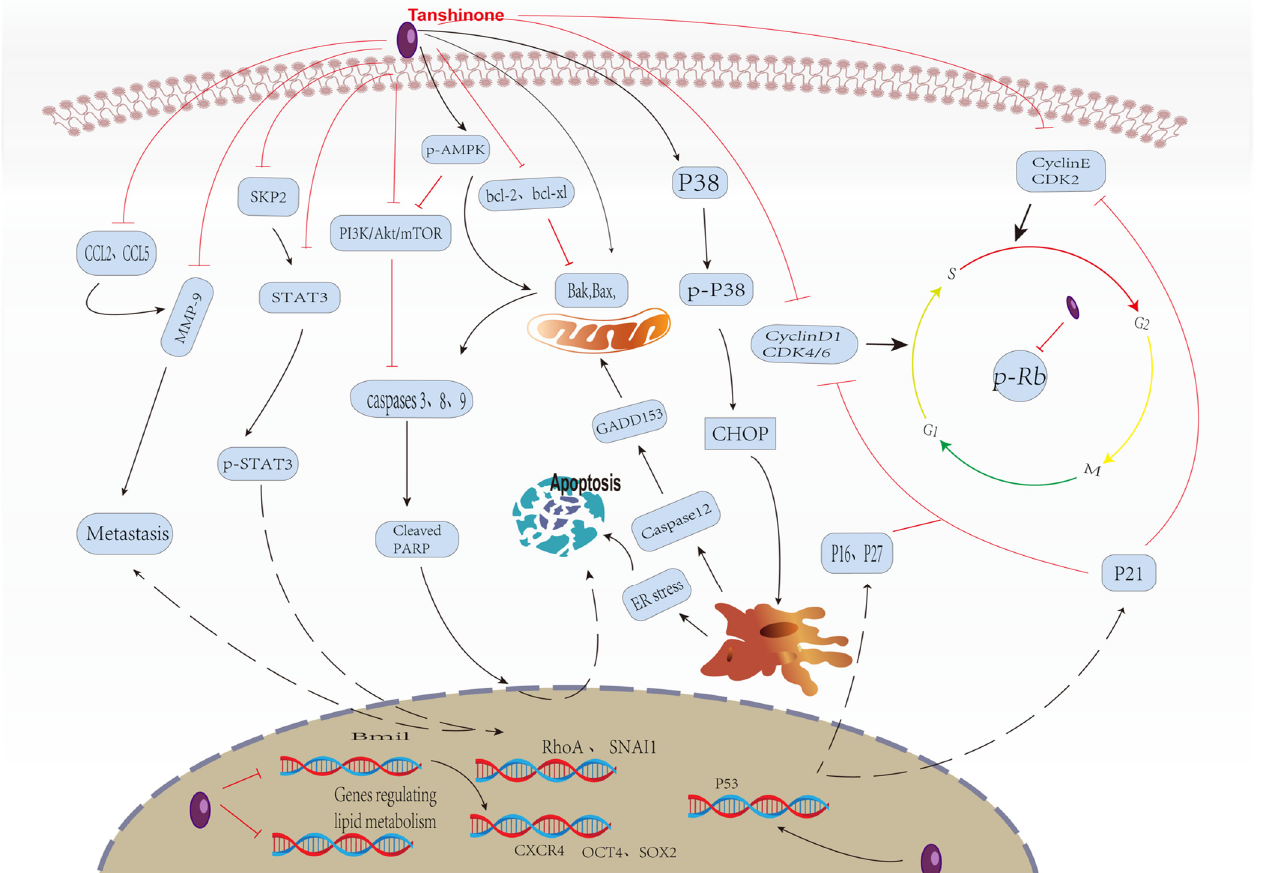
Figure 2. Effect of Tanshinone on prostate cancer. induced by Tanshinone are noted by using → , while the inhibition represented by ⊣ symbol.